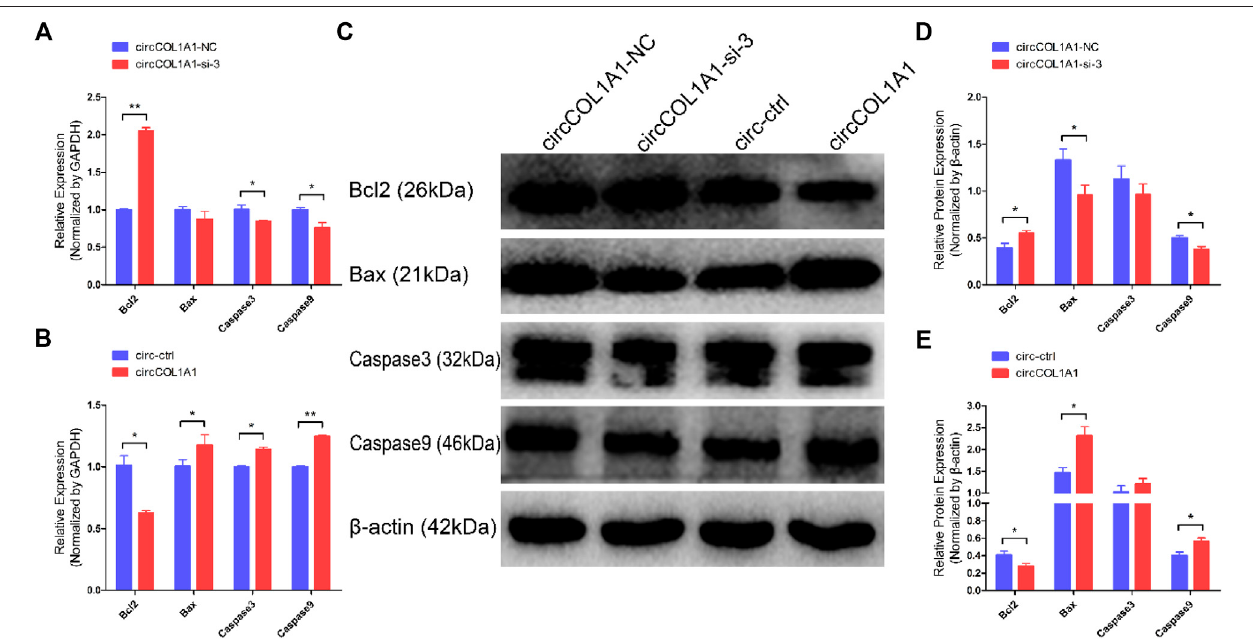
FIGURE 4 | CircCOL1A1 facilitates goat hair follicle stem cell apoptosis. (A,B) The relative mRNA expression of Bcl2, Bax, Caspase3, and Caspase9 at 48 h after transfection with circCOL1A1-si-3 (A) and circCOL1A1-overexpressing plasmid (B) . (C) Protein expression of Bcl2, Bax, Caspase3, and Caspase9 at 48 h after transfection with circCOL1A1-si-3 and circCOL1A1-overexpressing plasmid. (D,E) Relative protein expression of Bcl2, Bax, Caspase3, and Caspase9 at 48 h after transfection. (F,G) The cell apoptosis rate was detected at 48 h after transfection with circCOL1A1-si-3 by Annexin V-FITC/PI double staining followed by the fl ow cytometryassay. (H,I) Thecellapoptosisratewasdetectedat48 haftertransfectionwiththecircCOL1A1-overexpressingplasmidbyAnnexinV-FITC/PIdoublestaining followed by the fl ow cytometry assay.